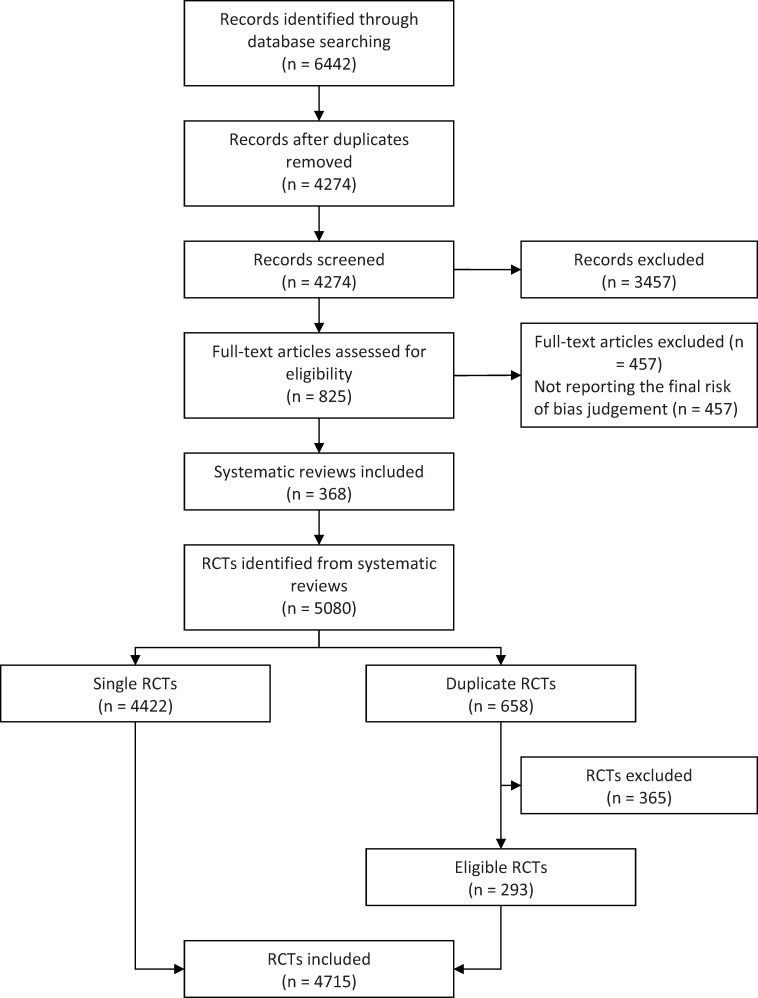
PRISMA flow diagram.